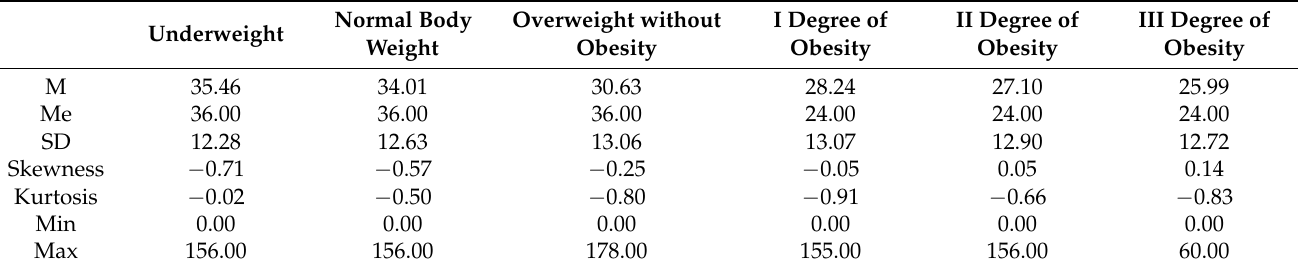
Table 2. Descriptive statistics on the average number of months of the issued medical certificate depending on BMI.